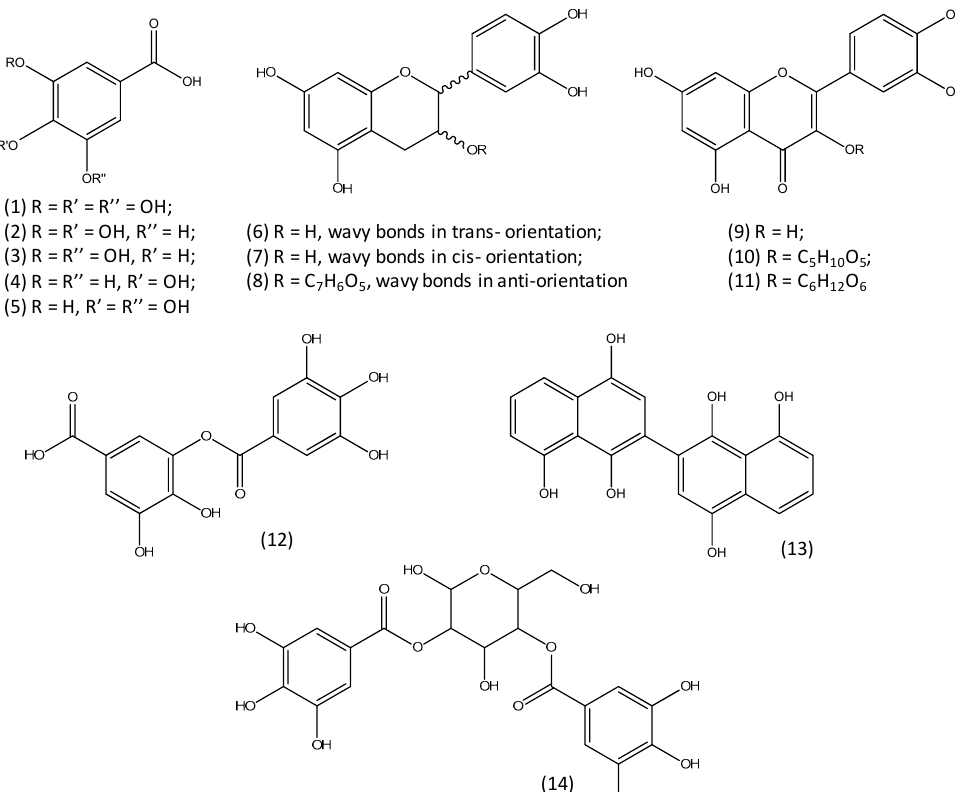
Figure 1. Structures of some representative tannins identified in the reference samples: (1) gallic acid; Figure